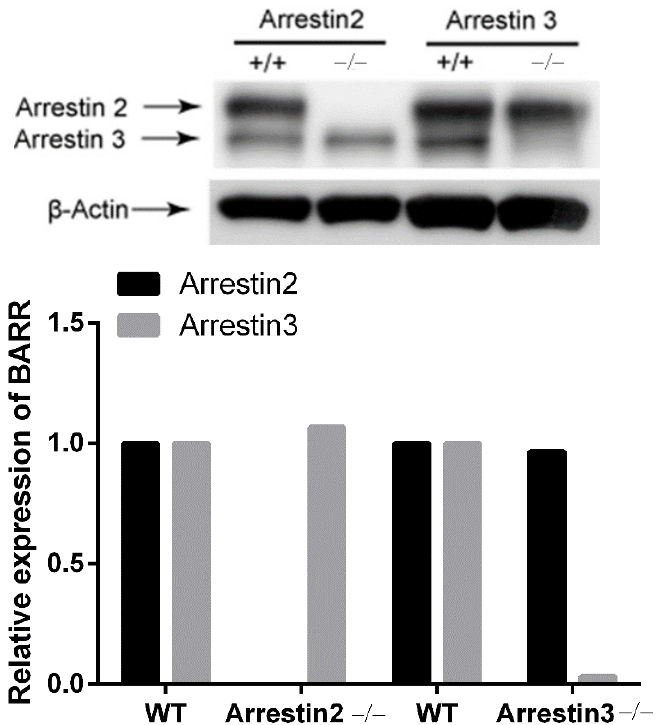
Figure 1. Expression levels of arrestins in platelets. Washed platelets from arrestin2 and arrestin3 +/+ and − / − mice were lysed and probed with anti-arrestin2/3 and anti- β -actin antibodies. Blots are quantified and presented as mean. Statistical analysis was conducted by Student’s t -test using Prism software (version 3.0). At least three individual experiments are represented in the Western blots.